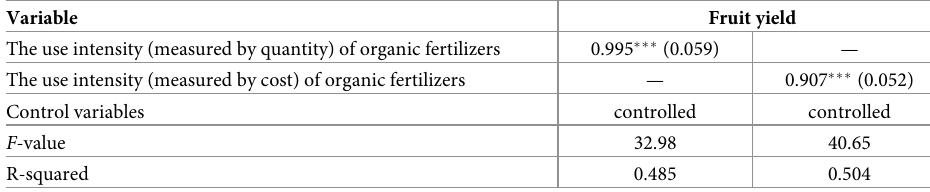
Note: ��� indicates the significance at the 1% levels. Standard error in parentheses. The dependent variables refer to the log-transformed forms of fruit